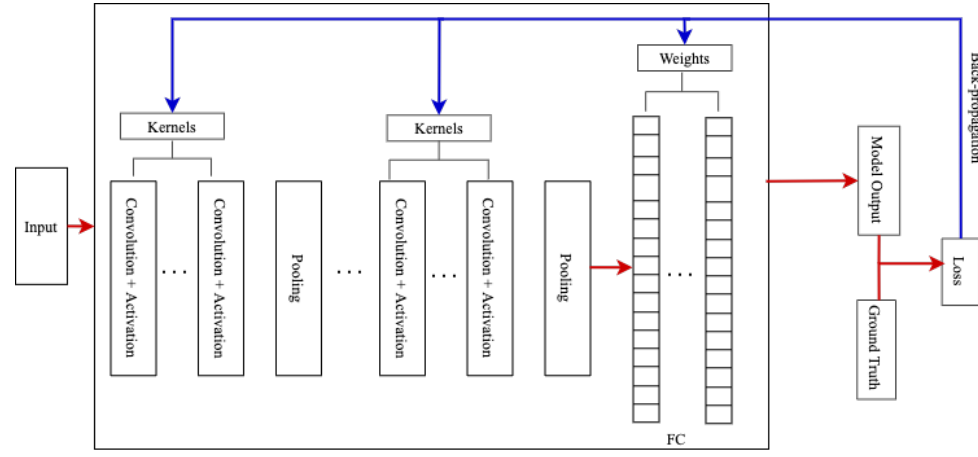
Figure 4. A typical CNN